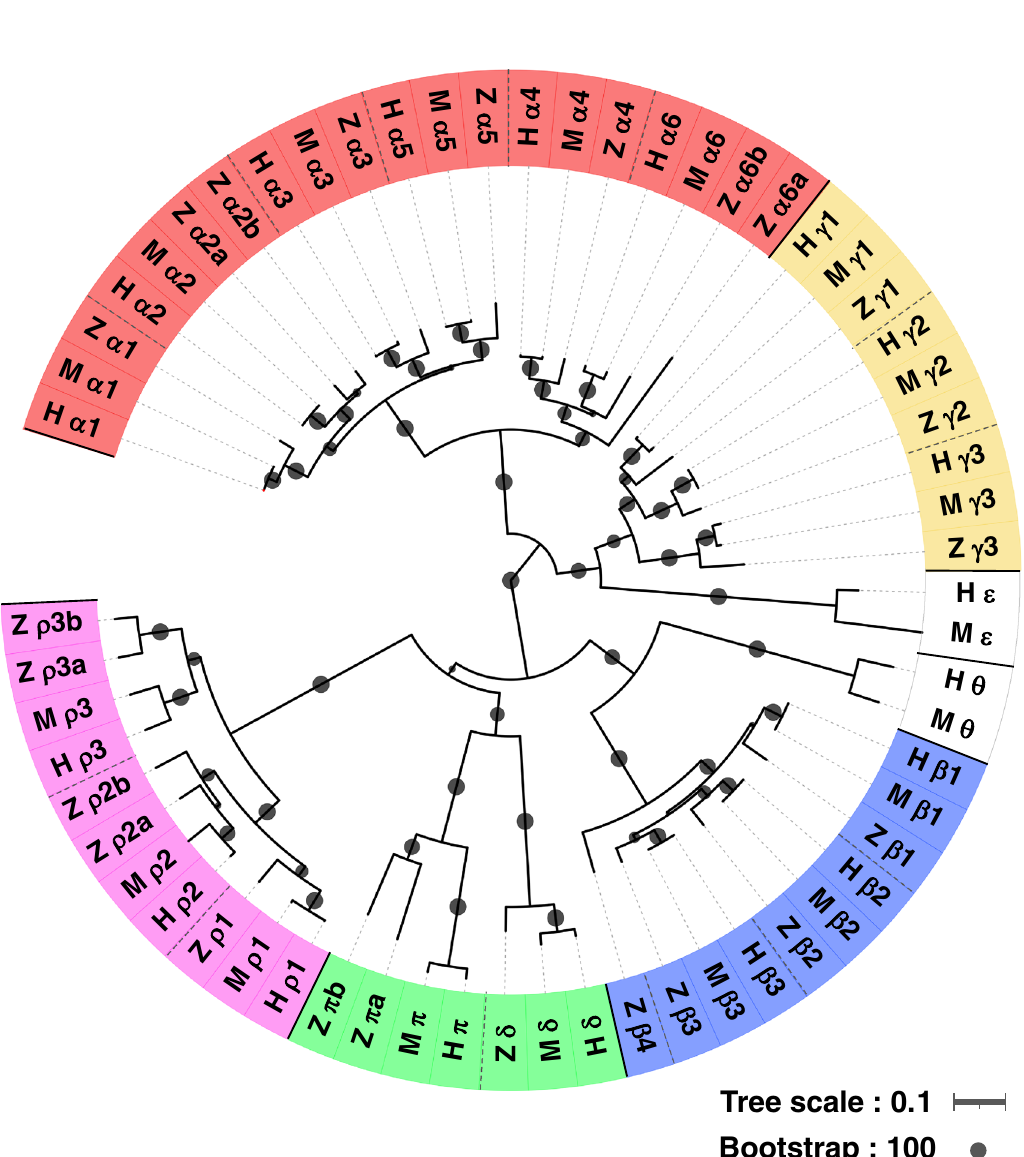
Figure 1. A phylogenetic tree of GABA A receptor subunits. Amino acid sequences of GABA A receptor subunits from humans, mice, and zebrafish were used to create a phylogenetic tree. This phylogenetic tree detected the subfamilies of α, γ/ ε, β/ θ, δ/π, and ρ. H: human; M: mouse; Z: